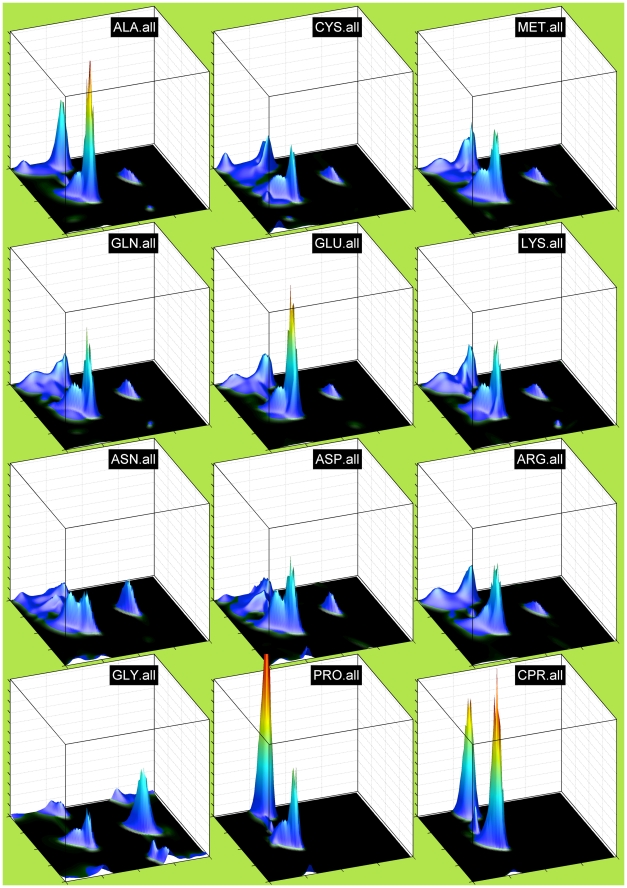
Neighbor-independent Ramachandran distributions (probability densities) for 12 amino acid types including cis proline (CPR) from the HDP simulation (see Figure 2 for remaining amino acid types).The axes are as follows: x-axis (horizontal) = φ from −180° to 180° with gridlines and ticks at −180°, −90°, 0°, +90°, and +180°. y-axis = ψ from −180° to 180°. z-axis (vertical) = probability density functions. All plots are scaled to a common maximum probability height, the third highest peak among all plots. Thus, Gly and Pro extend beyond the plotted vertical axis.